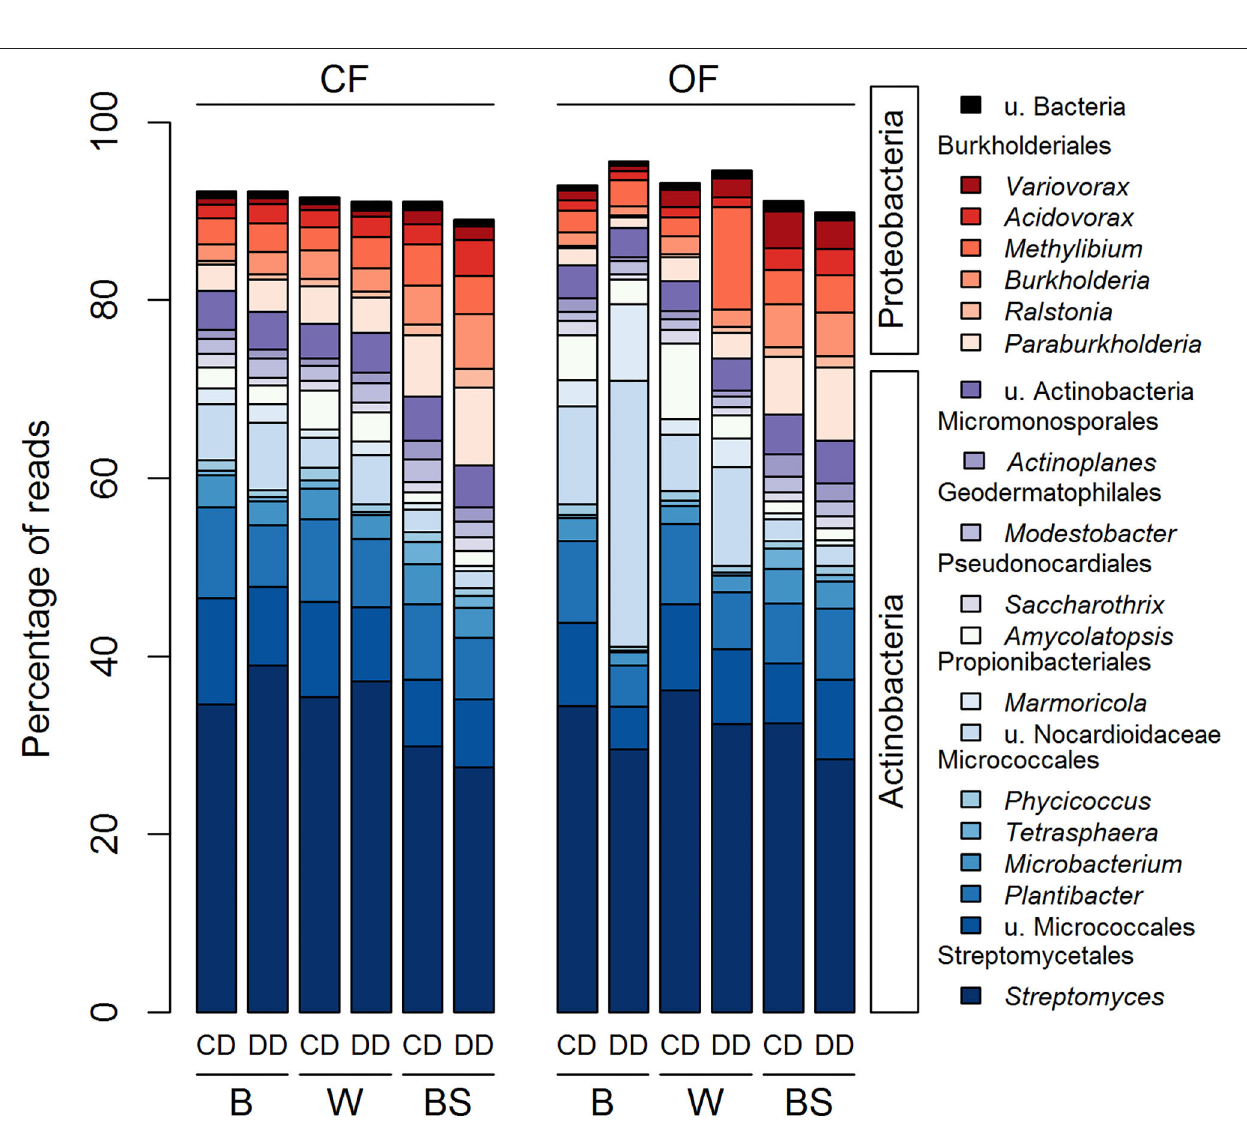
2020), which represents a threat to plant water and